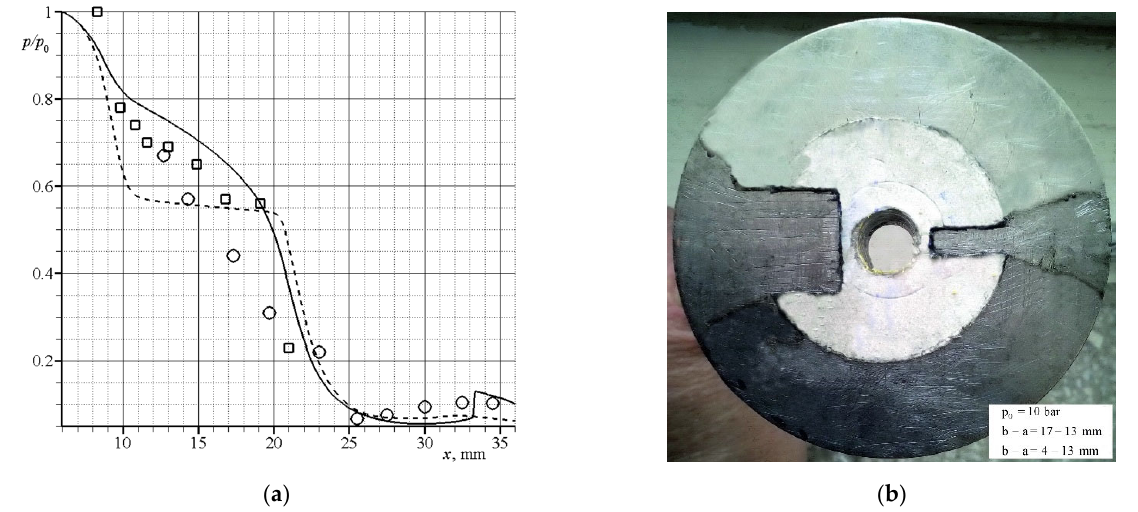
Figure 7. Results of experiments and calculations performed at h = 0.2 mm: ( a ) distributions of static pressure on the surface of the outer disk on the axis y = 0 in the experiment (symbols) and in the calculations (solid line); ( b ) soot-oil coating on the surface of the outer disk in the presence of two channels of width b = 17 mm and b = 4